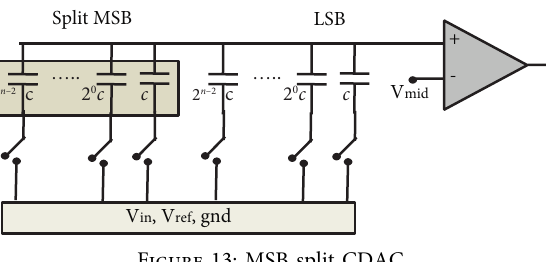
Figure 13: MSB split CDAC.